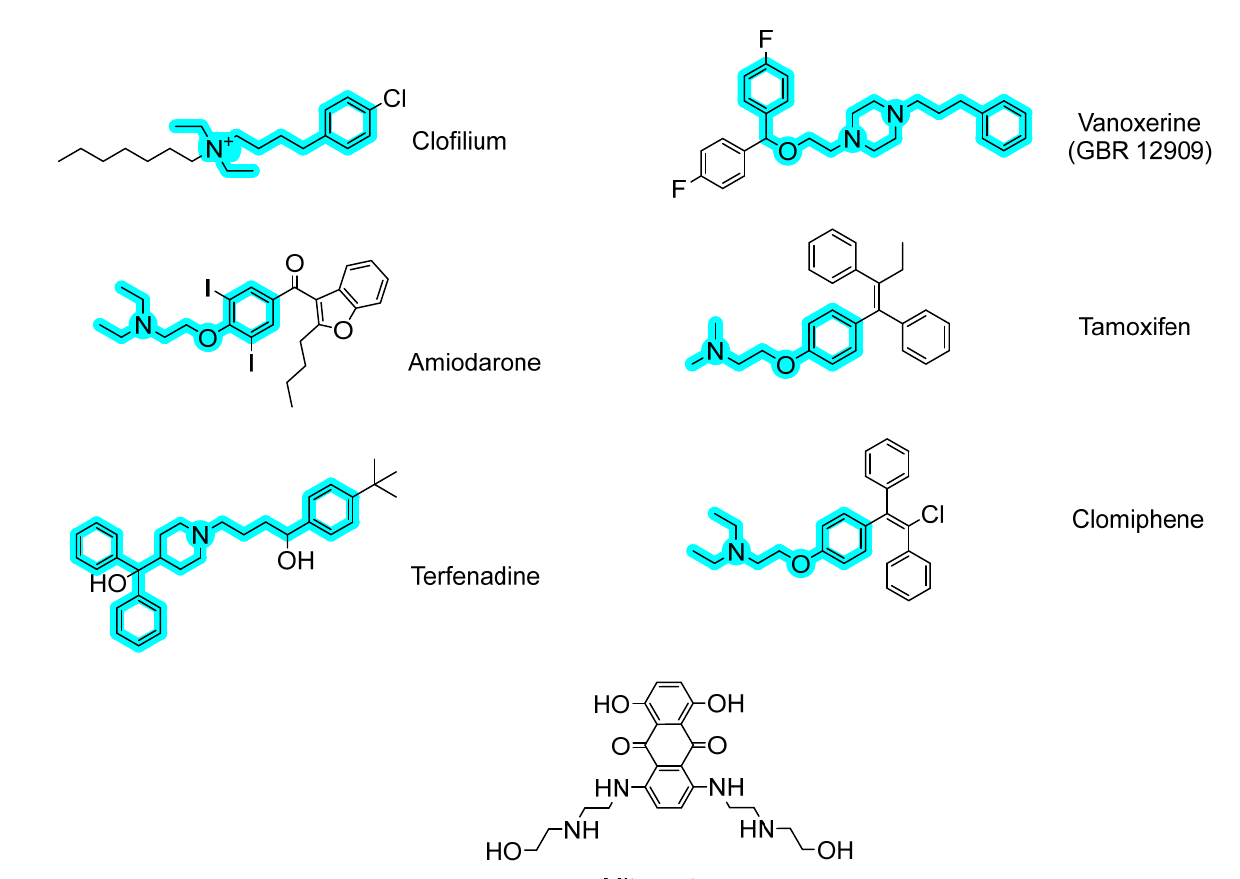
Figure 3. Structures of compounds affecting pneumococcal viability in more than 90%. The fragment structure common to all molecules except mitoxantrone is highlighted in cyan.